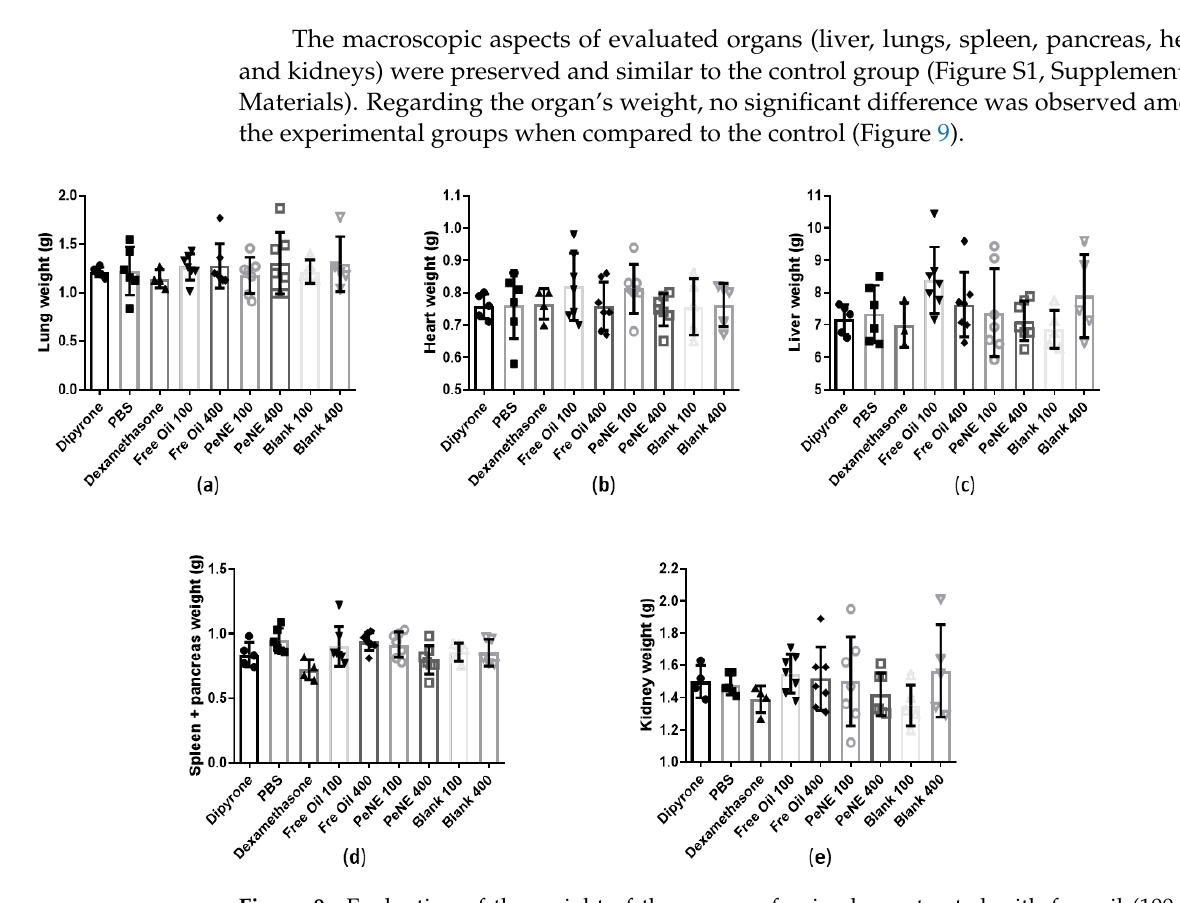
Figure 10. Histopathological evaluation. Representative photomicrographs of ( A ) liver, ( B ) kidney, ( C ) spleen, ( D ) pancreas, ( E ) lung, and ( F ) hearts of animals pre-treated with free oil (100 and 400